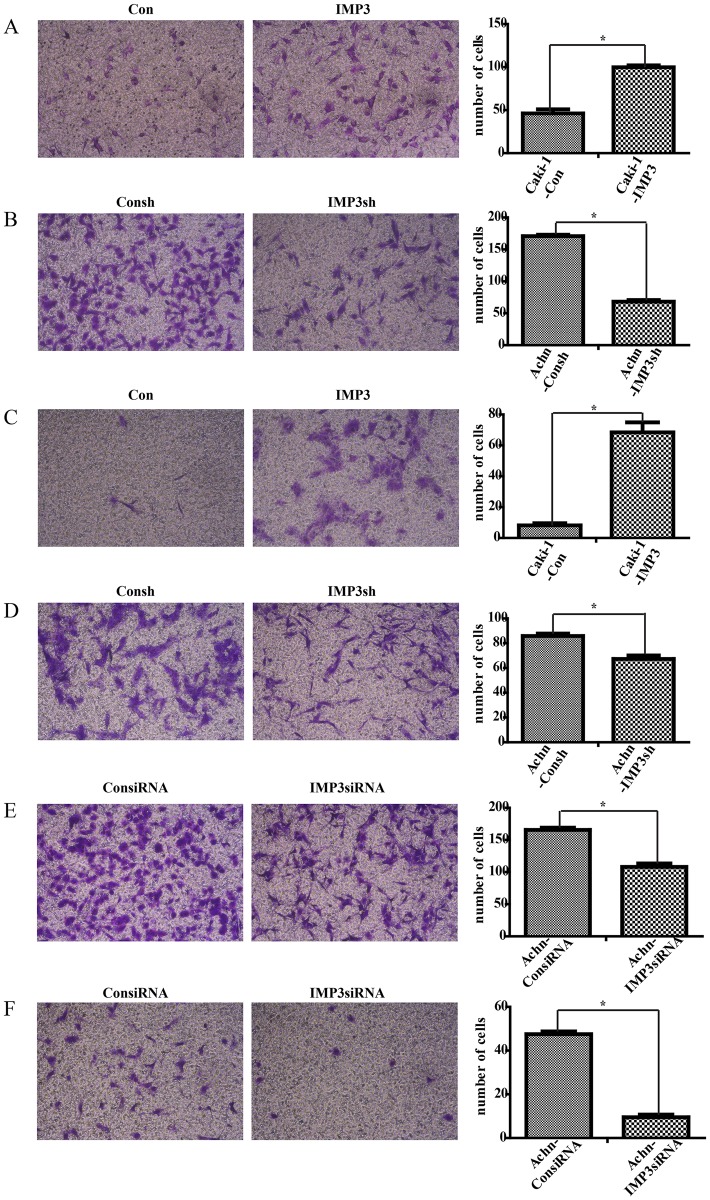
IMP3 promotes RCC cell migration and invasion.Transwell migration and invasion assays were used to detect the migration and invasion ability of RCC cells with IMP3 stable overexpression or knockdown. Migration of RCC cells with stable IMP3 overexpression or knockdown was measured. Caki-1-con and Caki-1-IMP3 cells (A), Achn-con shRNA and Achn-IMP3 shRNA cells, * p<0.0001 (B). Invasion of RCC cells with stable IMP3 overexpression or knockdown was measured. Caki-1-con and Caki-1-IMP3 cells, * p<0.0001 (C). Achn-con shRNA and Achn-IMP3 hRNA cells, * p<0.05 (D). Achn cells were transfected with control siRNA or IMP3 siRNA for 48 h and then the migration (E) and invasion (F) were detected. Values shown are mean ± SEM of three independent experiments. * p<0.05 vs. control group.